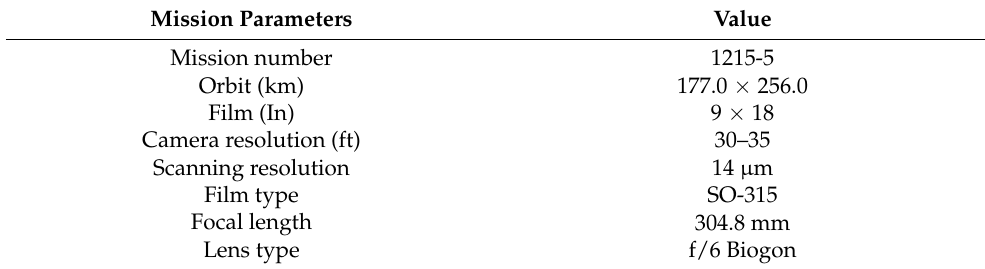
Table 2. Hexagon KH-9 sensor